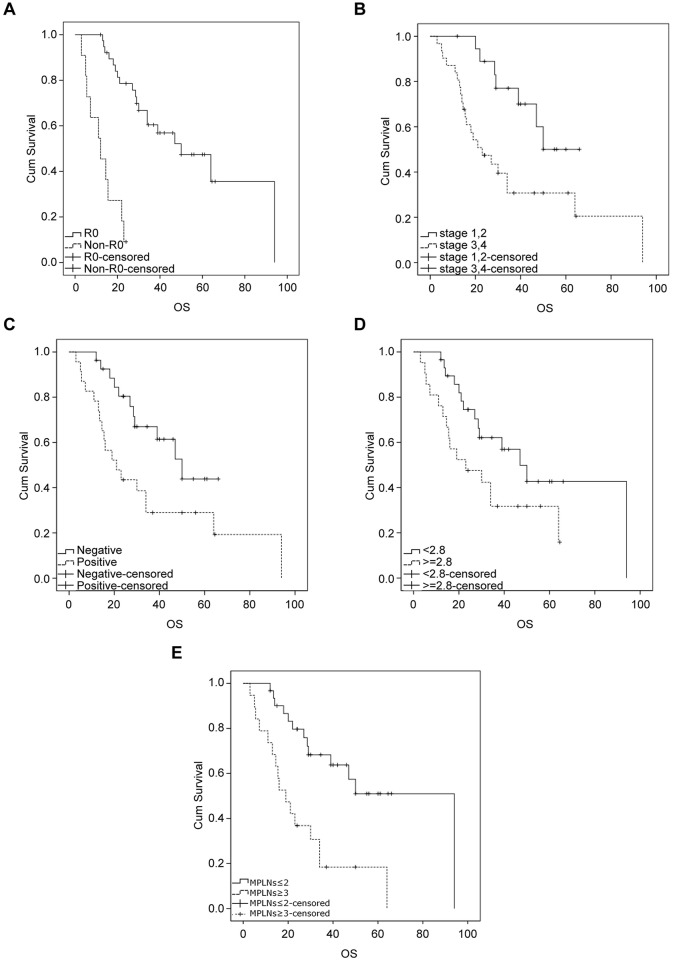
Kaplan-Meier survival curves for OS.(A) Surgery type (R0 vs. non-R0), P = 0.000; (B) TNM staging (I, II vs. III, IV), P = 0.016; (C) PET/CT LN (negative vs. positive), P = 0.029; (D) SUVmax of PET/CT LN (< 2.8 vs. ≥ 2.8), p = 0.021. (E) Number of 18F-FDG-positive LN (≤ 2 vs. ≥ 3), P = 0.0009. Tick marks indicate censored events.